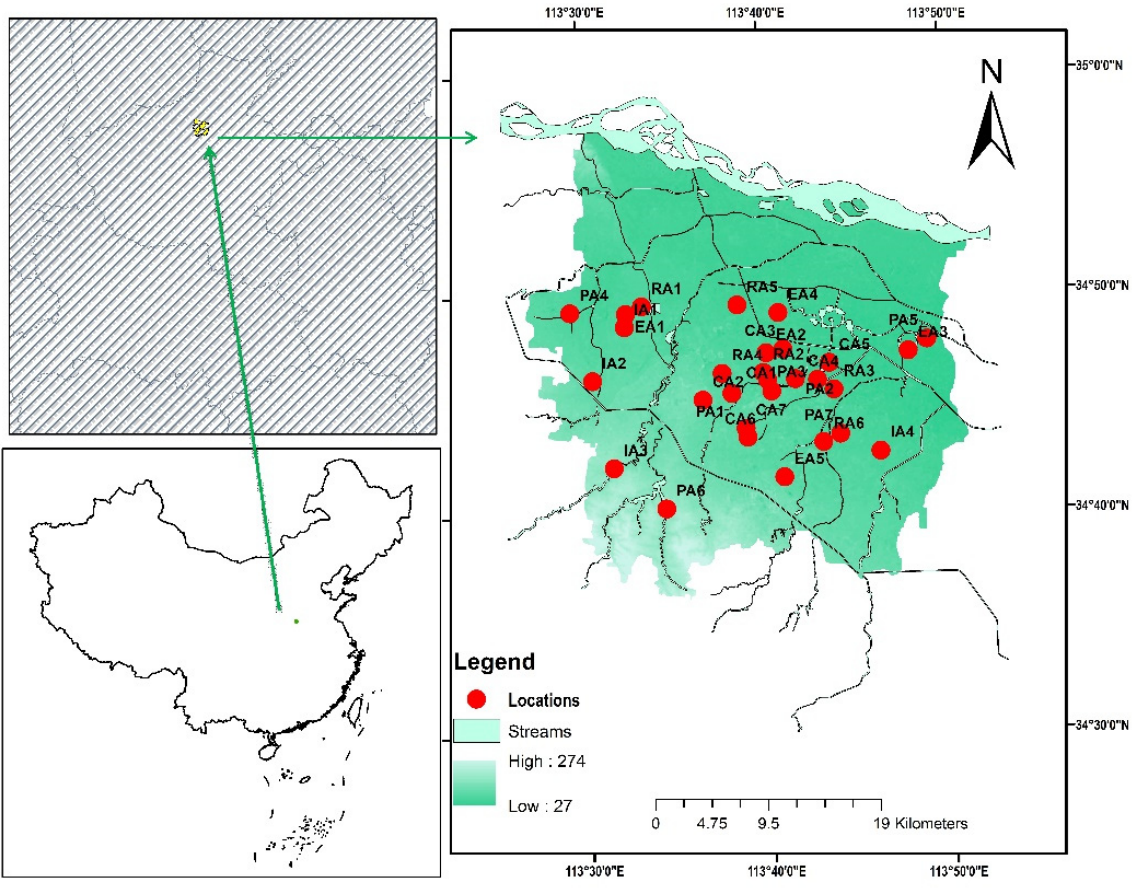
Figure 1. Study Area of Zhengzhou city.